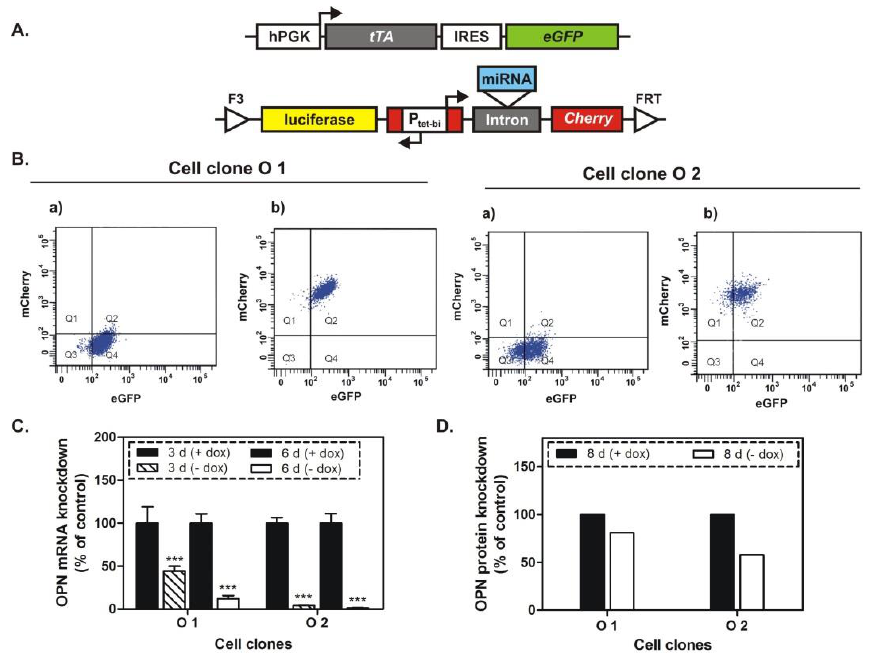
Figure 1. The expression of osteopontin is regulated by a specific miRNA, which is expressed in the absence of doxycycline (dox). ( A ) Two gene cassettes were integrated into the genome of MDA-MB-231 breast cancer cells and thus generated the double transgenic cell clones O1 and O2; Abbreviations used: hPGK—human phosphoglycerate kinase promoter; tTA—tetracycline-controlled transactivator; IRES—internal ribosome entry site; eGFP—enhanced green fluorescent protein; luciferase—firefly luciferase; Ptet-bi—bidirectional tet-regulated promoter; Cherry—red fluorescent protein mCherry; FRT and F3—wild type and mutant; Flp—recombinase target sites. ( B ) Flow cytometry analysis of the transgenic cell clones O1 and O2; ( a ) Fluorescence from cell clones cultivated in medium with doxycycline; ( b ) mCherry expression was stimulated upon removal of doxycycline from the